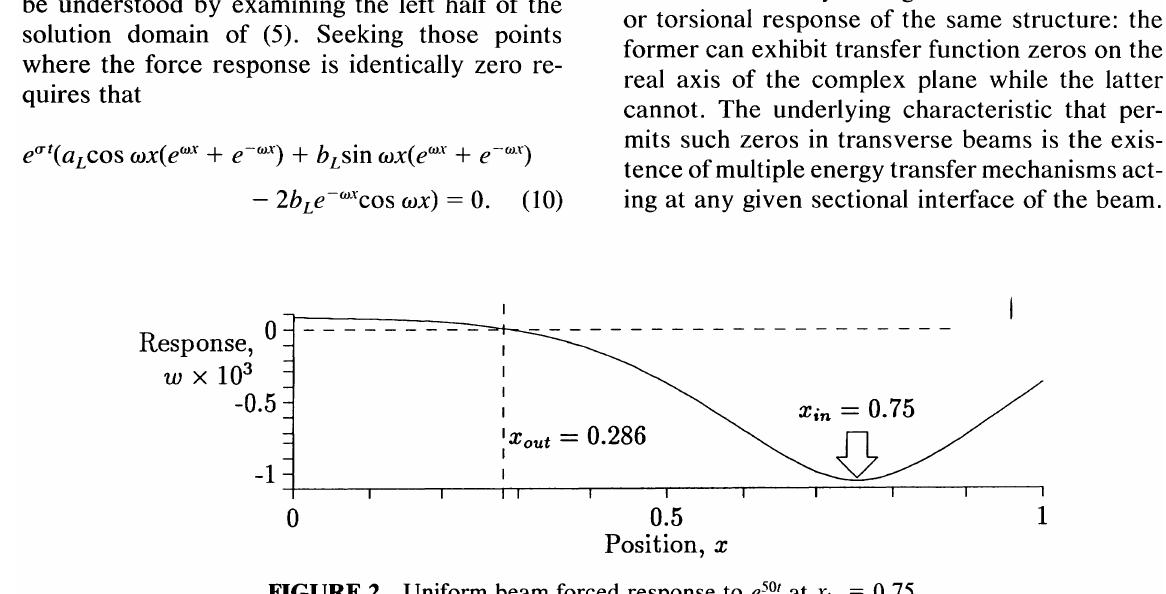
FIGURE 2 Uniform beam forced response to e 50t at Xin =